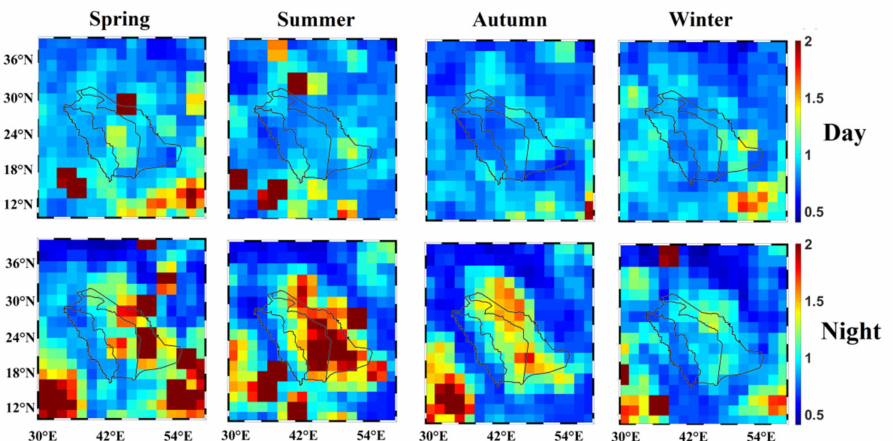
Figure 12. Seasonal spatial distributions of VDR 1 over Saudi Arabia from 2007 to 2019.